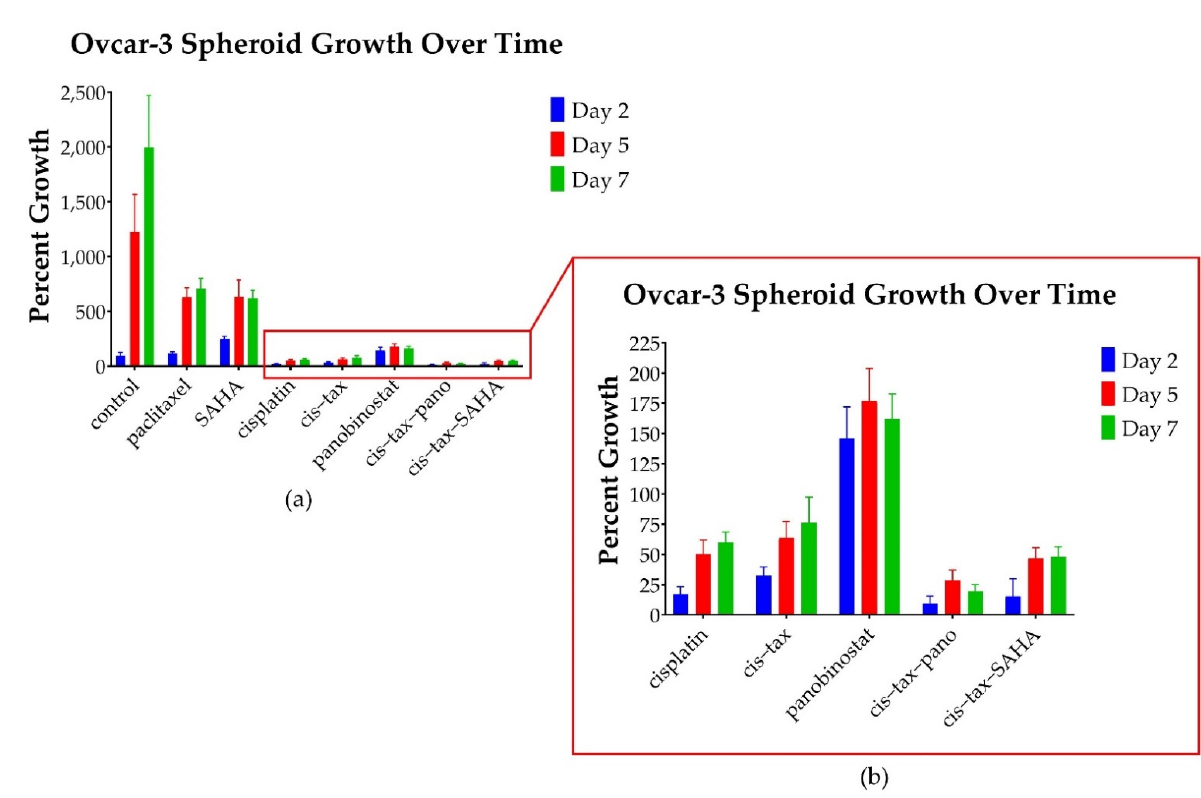
Figure 7. Percentage growth of cisplatin-resistant Ovcar-3 spheroids at selected timepoints under various treatments. ( a ) Control spheroids grow to 1994% their original size, whereas those exposed to paclitaxel and SAHA grow to 706% and 620% of their original size ( p = 0.01) However, other treatments are far more effective. No treatments affect spheroid shrinkage. ( b ) Spheroids exposed to panobinostat grew to 162% of their original size ( p = 0.01), whereas, those exposed to the combination of cisplatin–paclitaxel-panobinostat grew to 19% of their original size ( p = 0.01) and those exposed to the combination of cisplatin–paclitaxel-SAHA grew to 48% of their original size ( p = 0.029). Spheroids exposed to cisplatin grew to 60% of their original size ( p = 0.016). The spheroids exposed to the combination of cis–tax grew to 76% their original size ( p = 0.29) ( n = 4).